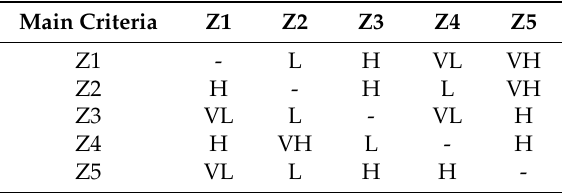
Table 7. Linguistic ratings of the main criteria given by an expert group.